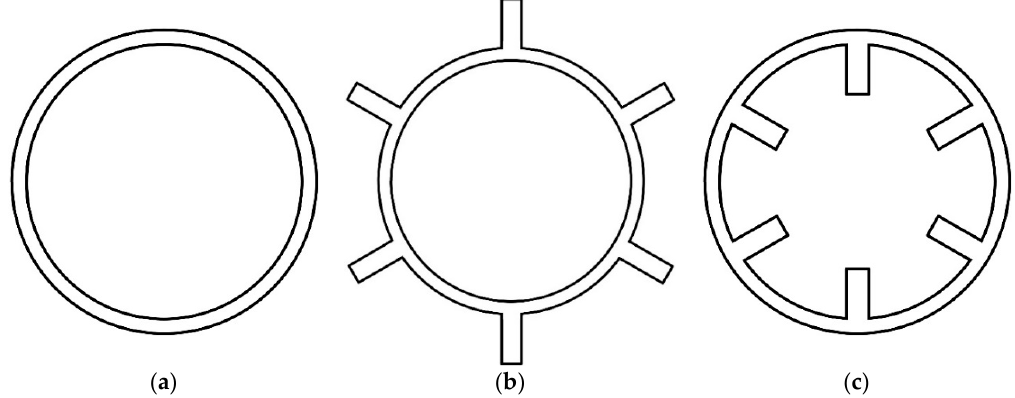
Figure 2. Cross-sections of smooth and finned U-tubes: ( a ) simple U-tube; ( b ) U-tube with outer fins; ( c ) U-tube with inner fins.